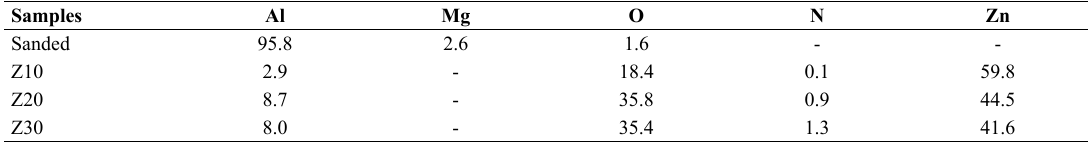
Table 1. EDS analysis on the surface after sanded process and after treatment with zinc nitrate in alkaline medium at different etching times of 10, 20 and 30 min, in wt%. Samples